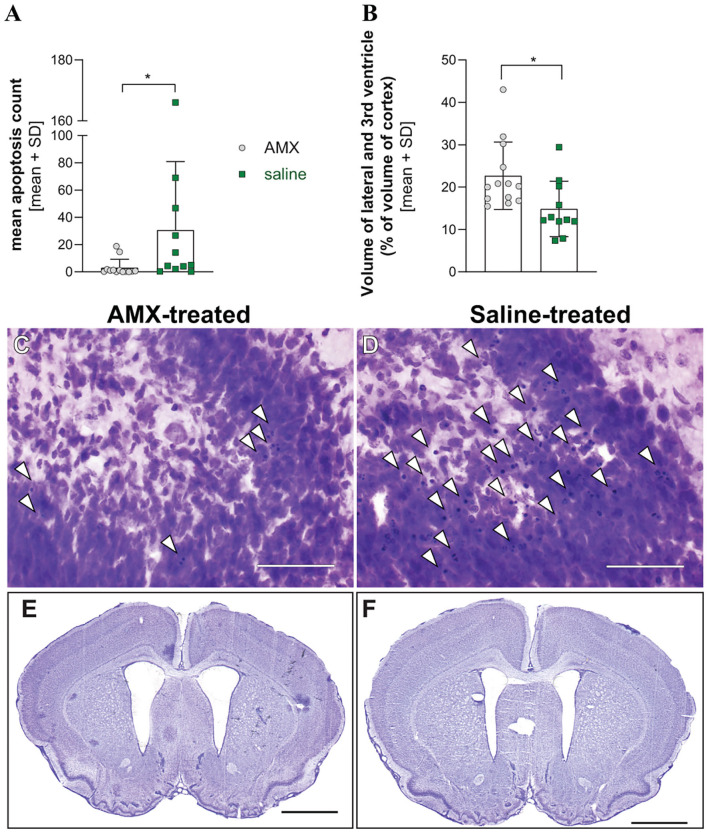
Histological parameters in infection with a mixture of the 4 RMS allele variants. Treatment of infected animals with AMX (n = 13) attenuated hippocampal apoptosis in comparison to saline-treated animals (n = 11) (A) but was associated with enlarged ventricle size (B). Representative pictures of cresy violet-stained sections of the apex of the dentate gyrus (C,D, bar size 50 μm), with examples of apoptotic cells indicated with white arrowheads, or from entire sections with enlarged lateral ventricles (E,F, bar size 2 mm). *p < 0.05.